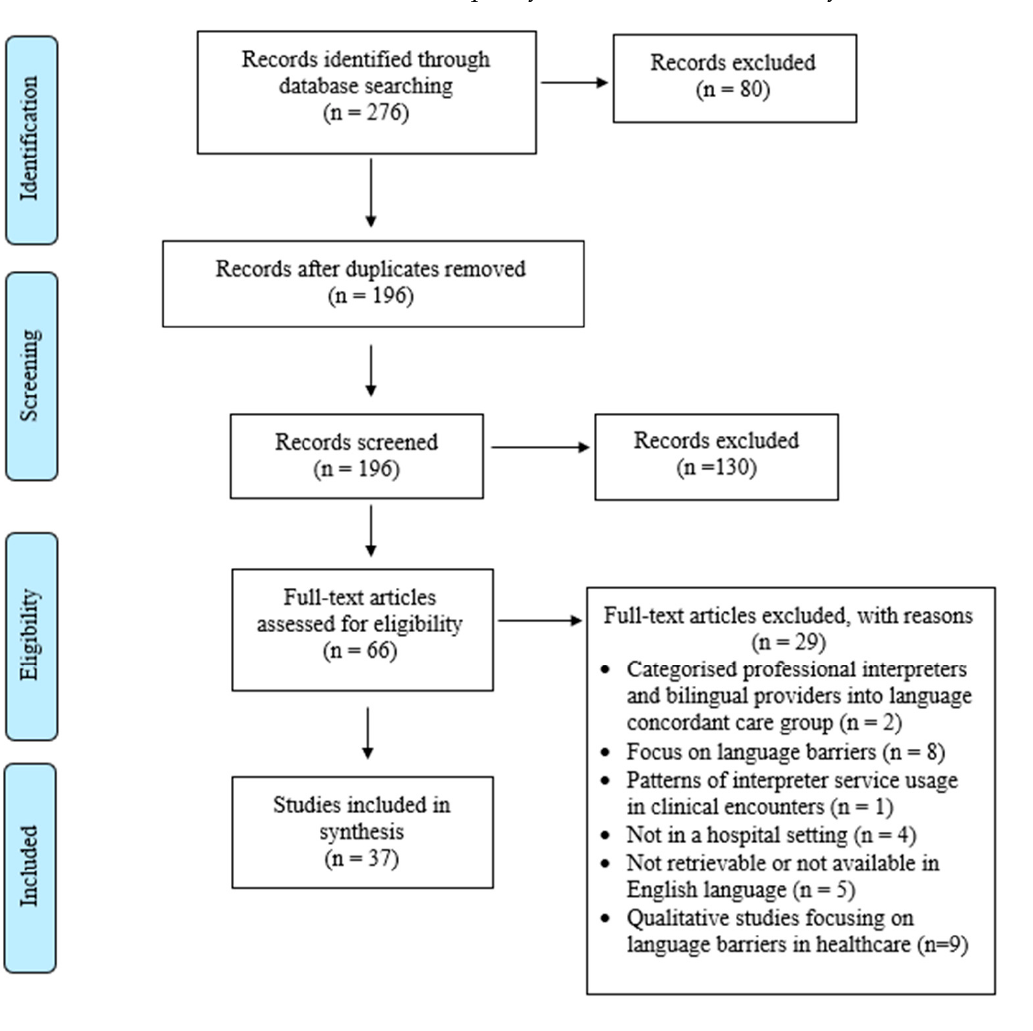
Figure 1. PRISMA flow chart presenting the screening and selection process of studies.